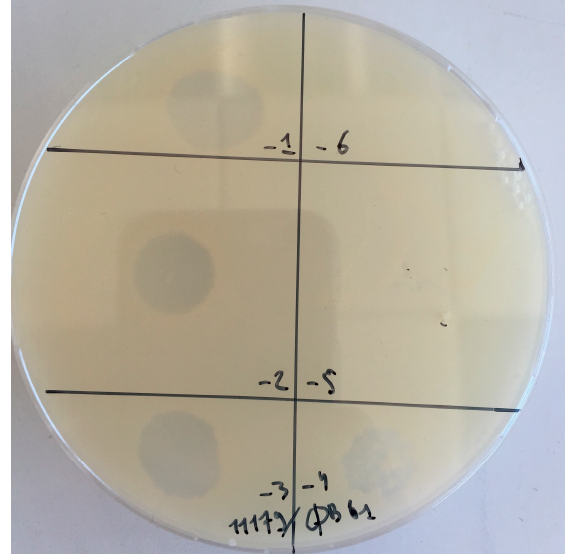
Figure 1. Plaques produced by phage GC1 on G . cerinus ATCC 11179.